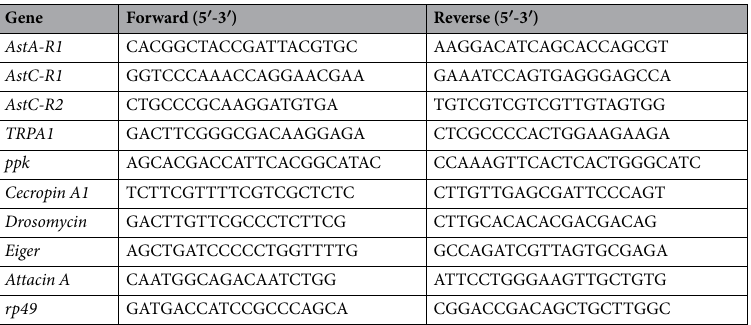
Table 2. Primers used in quantitative RT-PCR analysis of immune and nociception related genes in Drosophila melanogaster